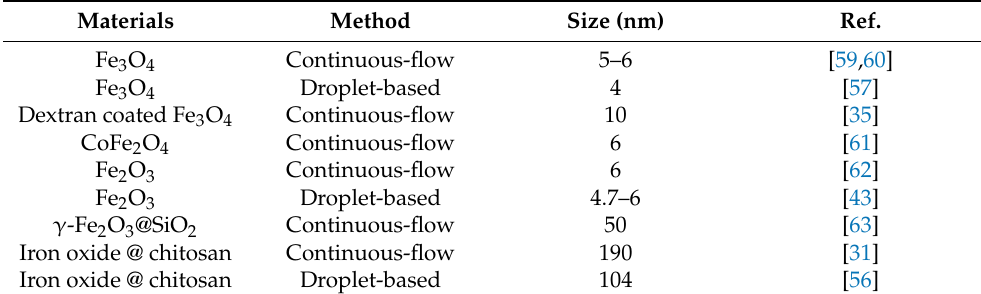
Table 1. Examples of microfluidic-based magnetic nanoparticle synthesizes.